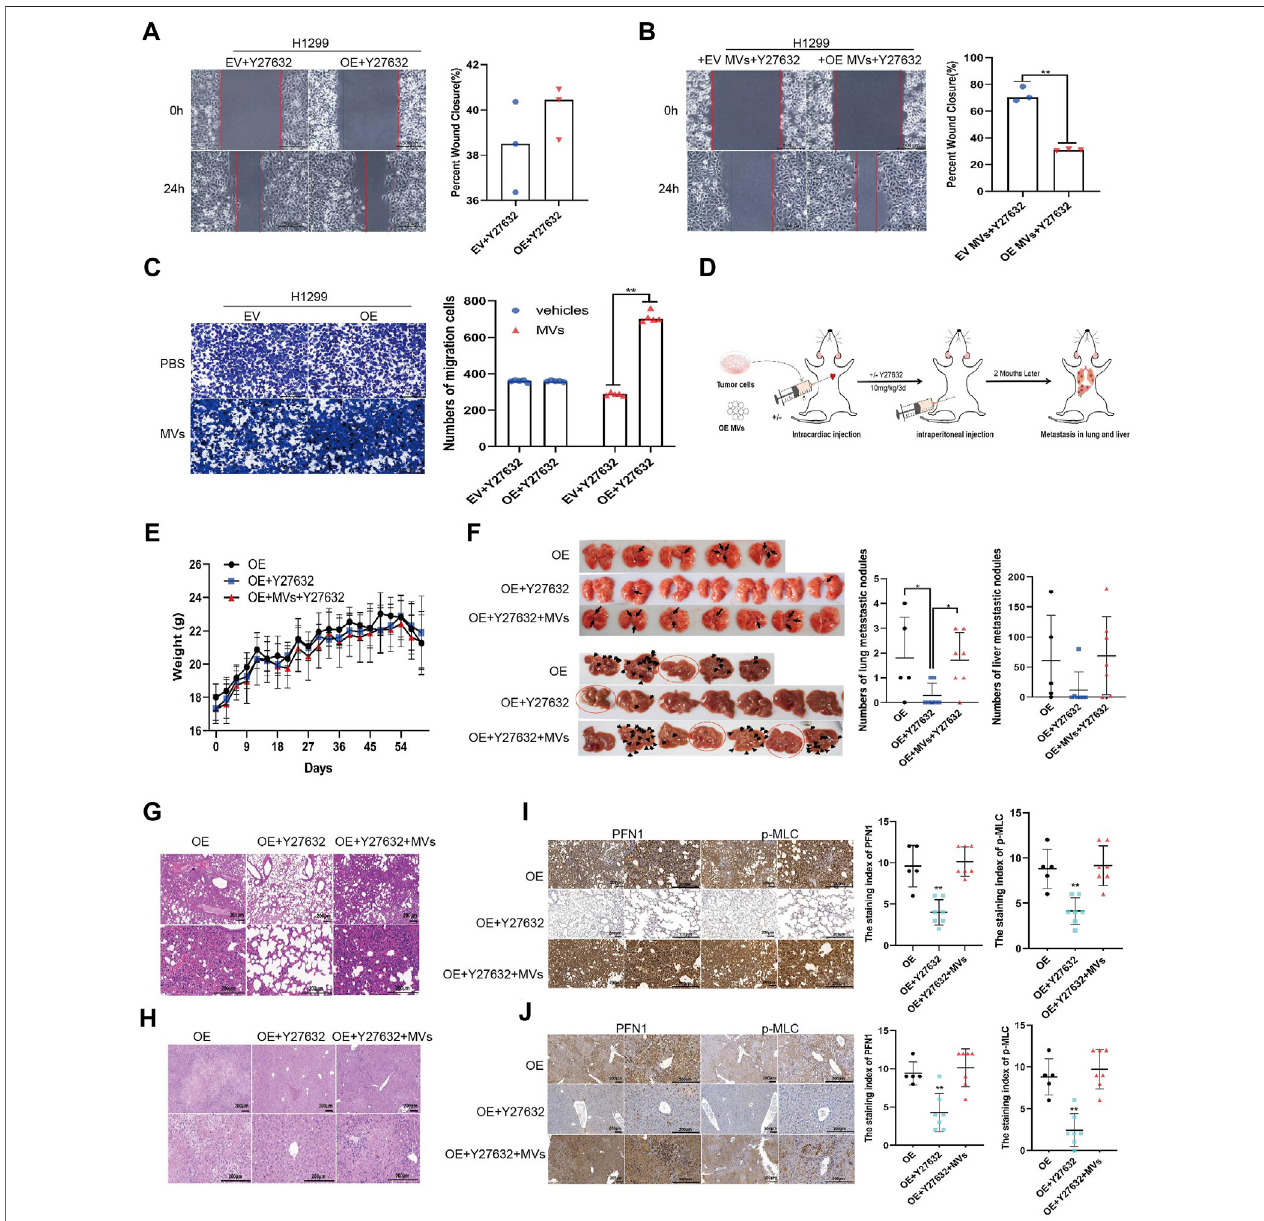
FIGURE 6 | ROCK1 inhibitor Y27632 partially reversed the promotion of lung cancer metastasis by PFN1 in vitro and in vivo . (A,B) Wound healing assays conducted to evaluate the effect of Y27632 (A) and Y27632 combined with MVs (B) on cell migration. ** p < 0.01; scale bar, 500 μ m. (C) Transwell migration assays conductedtoevaluatetheeffectofY27632andY27632combinedwithMVsoncellmigration.** p < 0.01;scalebar,500 μ m. (D) Schematicdiagramofthemousemodel of metastatic tumor established to determine the effect of Y27632 on PFN1-induced lung cancer metastasis. (E) Body weight changes in mice after intracardiac injection of PFN1 -overexpressing H1299 cells and intraperitoneal injection of Y27632 (10 mg/kg). (F) Representative images of lung and liver metastatic tissue in mice. The number of metastatic nodules is shown in the right-hand side graph. * p < 0.05. (G,H) Representative images of HE-stained lung (G) and liver (H) metastases. (I) Representative IHC images of PFN1 and p-MLC expression in lung tissues. The staining index is shown in the right-hand side graph. ** p < 0.01. (J) Representative IHC images of PFN1 and p-MLC expression in liver tissues. The staining index is shown in the right-hand side graph; ** p < 0.01.